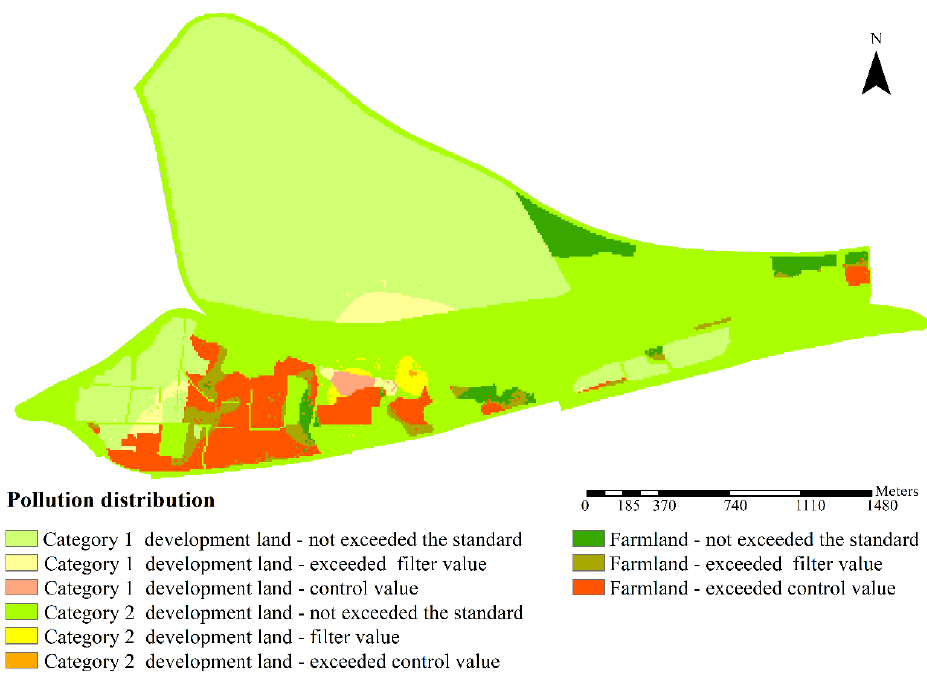
Figure 5. Distribution of Hg pollution for different land types in the study area.